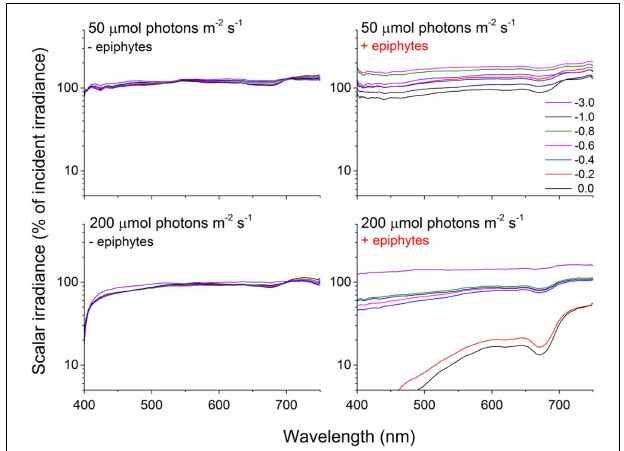
FIGURE 5 | Vertical microprofiles of the O 2 concentration measured toward the leaf surface under four different incident photon irradiances (0, 50, 100, and 200 µ mol photons m − 2 s − 1 ). Red symbols and lines represent leaves with 21% epiphyte-cover, Black symbols and lines represent leaves without epiphyte-cover. y = 0 indicates the leaf surface. Symbols and errors bars represent means ± SD. n = 3 –4; leaf level